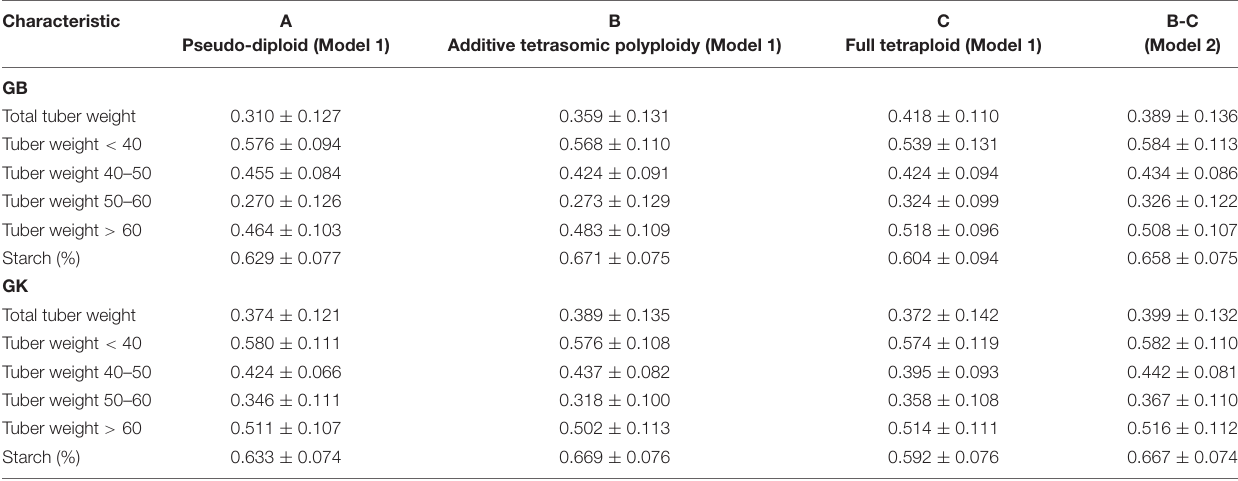
TABLE 2 | Single-environment genomic best linear unbiased predictor (GBLUP, GB) and Gaussian kernel (GK) prediction accuracy ( ± standard deviation) for potato tuber characteristics considering pseudo-diploid (A) (model 1), additive tetrasomic polyploid (B) (model 1), full tetraploid (C) (model 1), and B-C (model 2) with 30 random